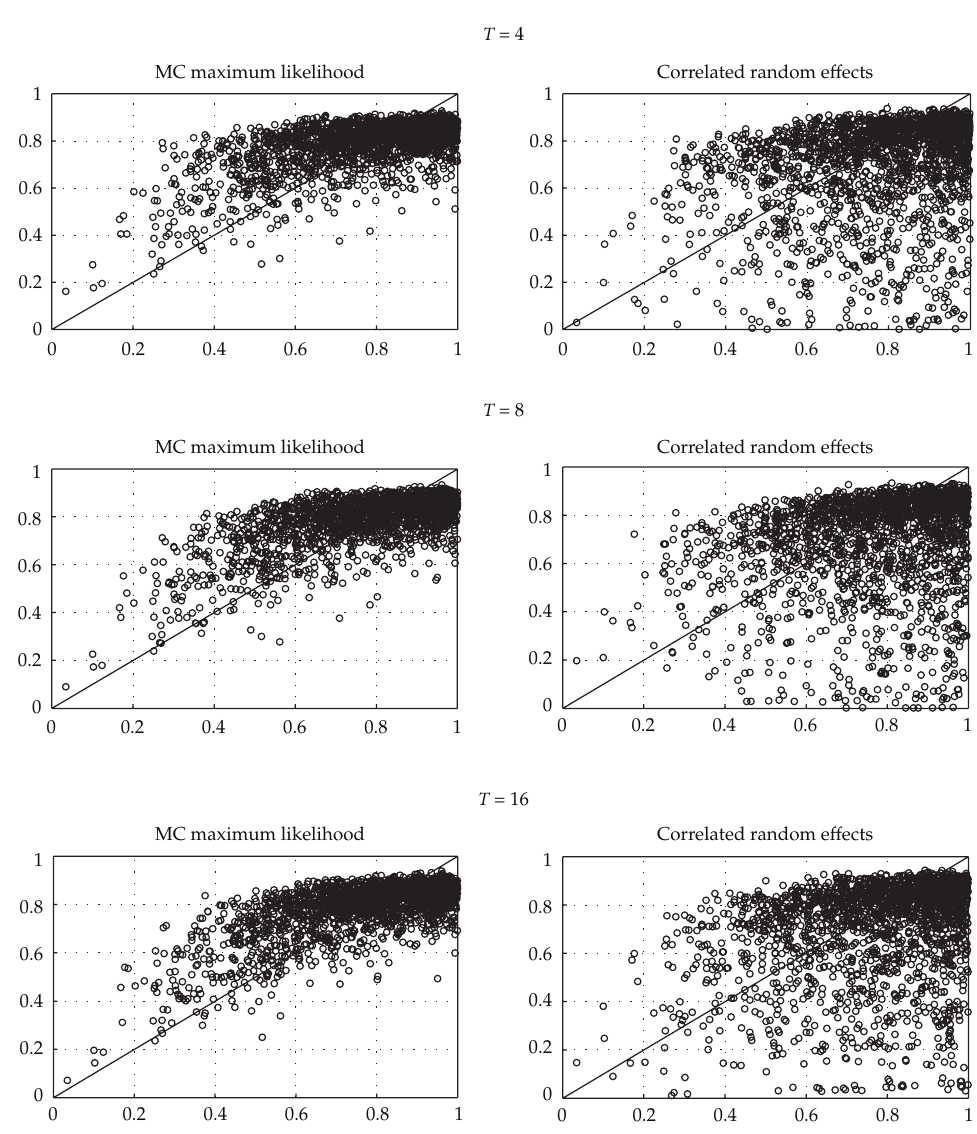
Figure 1: Actual versus predicted e ffi ciency scores with simulated